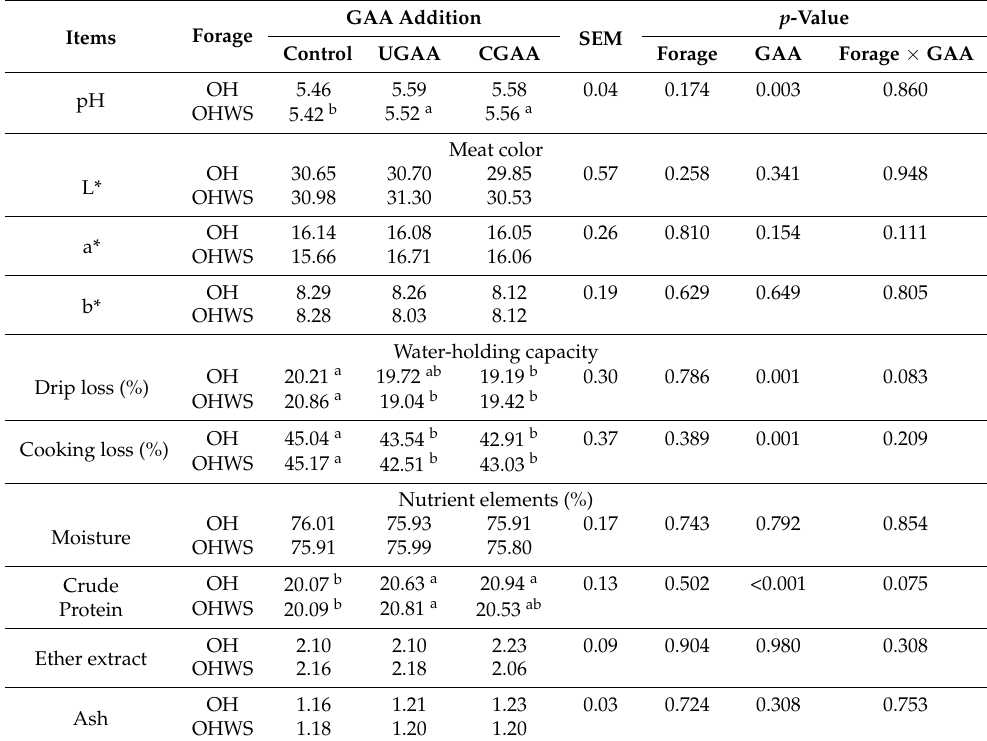
Table 6. Effects of forage type and GAA addition on meat quality traits in feedlotting